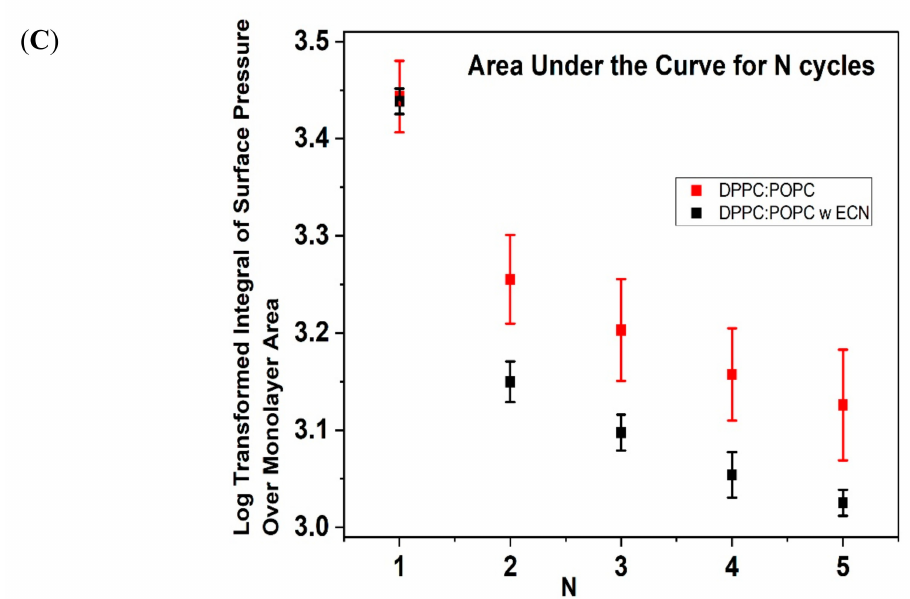
Figure 3. ( A ) Surface Pressure versus area isotherms for DPPC:POPC (7:3) without (control, red solid line) and with 1 wt% ECN (black solid line). Similar to the DPPC:POPG, DPPC:POPC samples were compressed and expanded five times. The data has been represented as the mean of 3 samples. ( B ) The initial part of the 4th and 5th compression cycles of DPPC:POPC monolayers with (black lines) and without (red lines) the ECN, showing the lift o ff area for each compression cycle. ( C ) Area under the curve as a function of compression / expansion cycle for DPPC:POPC (7:3) without (control, red square) and with 1 wt.% ECN (black square). Three samples were taken to obtain the log-transformed mean and standard